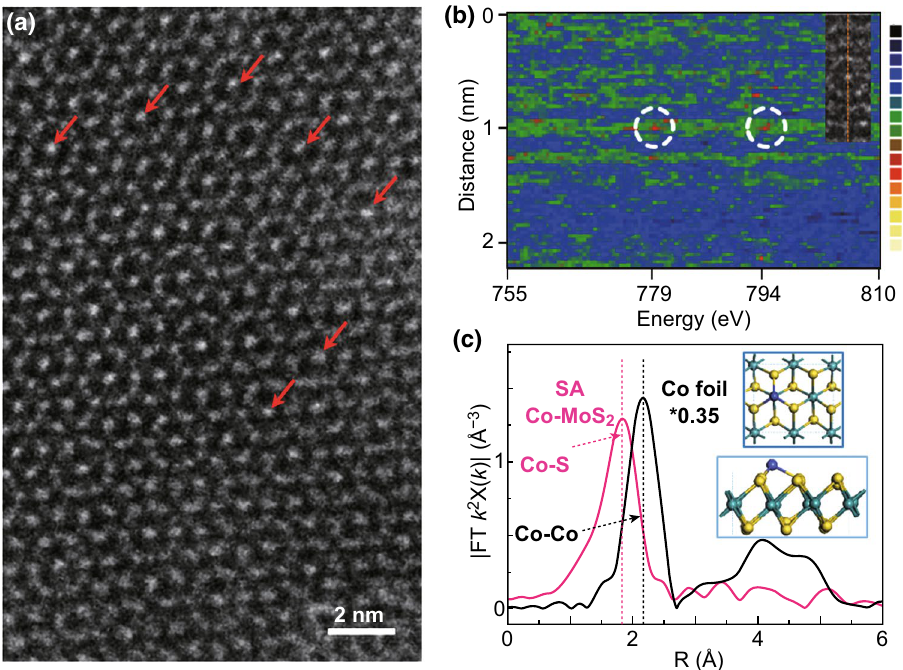
Fig. 1 a Aberration‑corrected HAADF‑STEM image of SA Co–MoS 2 . b EELS results of SA Co–MoS 2 . c FT‑EXAFS spectra of SA Co–MoS 2 and cobalt foil at the Co K‑edge. The inset shows the atomic structure of SA Co–MoS 2 . Yellow spheres: S; aqua spheres: Mo; slate blue spheres: Co. (Color figure